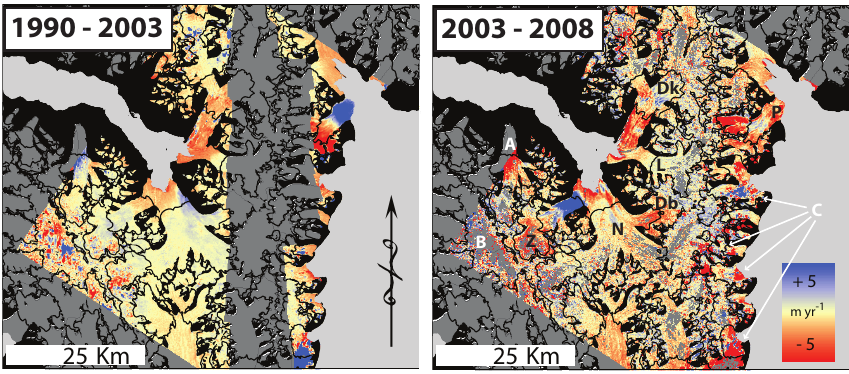
Fig. 11. Elevation changes from 1990–2003 and 2003–2008 after co-registration and adjusting for along/cross track biases. In the 2003–2008 image, we denote data artifacts using white upper case letters in which [A] and [B] are edge effects and [C] are cloud anomalies. Black upper case letters represent individual glacier trends described in the text; [Z] Zawadskibreen, [N] Nathorstbreen, [Db] Dobrowolskibreen, [L] Liestølbreen, [Dk] Doktorbreen, [P] Perseibreen.